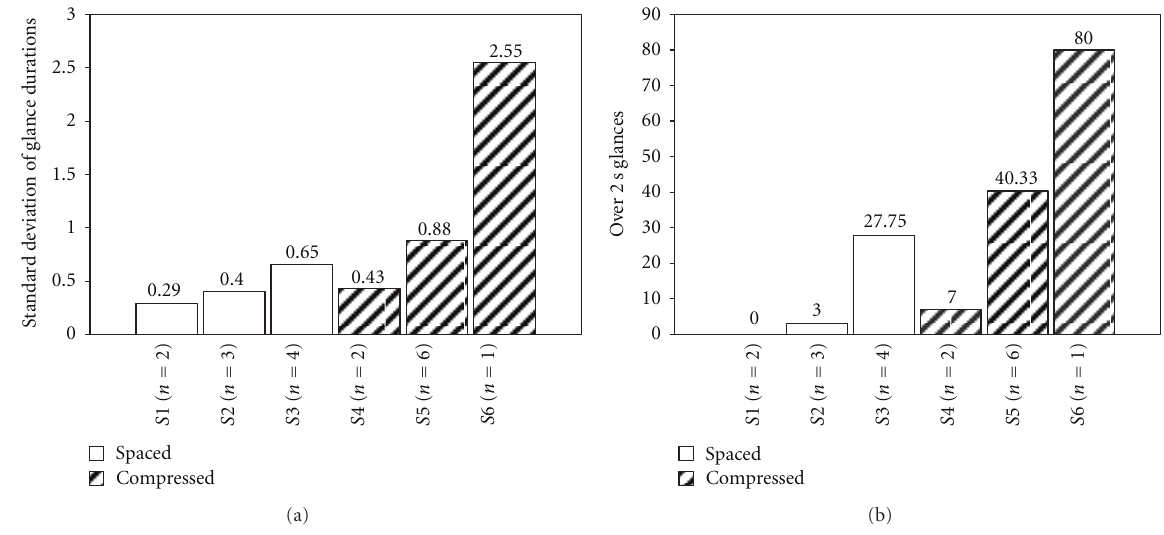
Figure 5: Visual sampling strategy versus mean values of visual sampling e ffi ciency measures in Experiment 2.